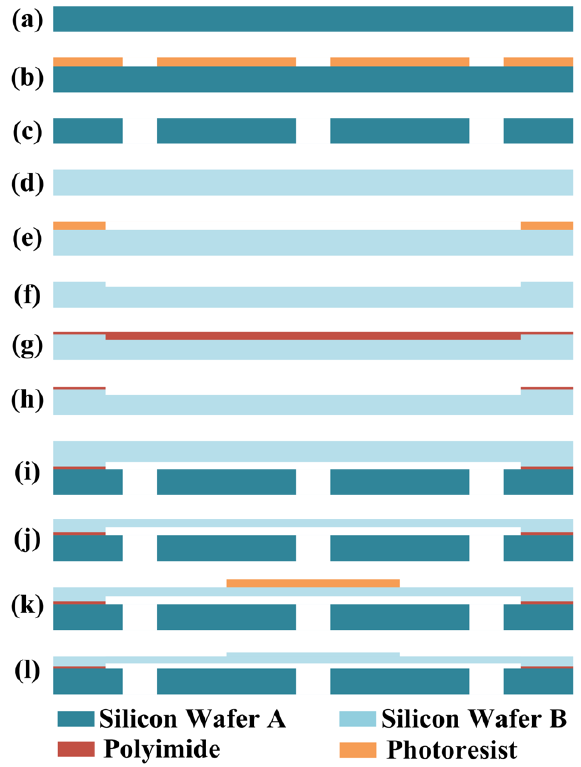
Figure 4. Fabrication process of the micro valve.